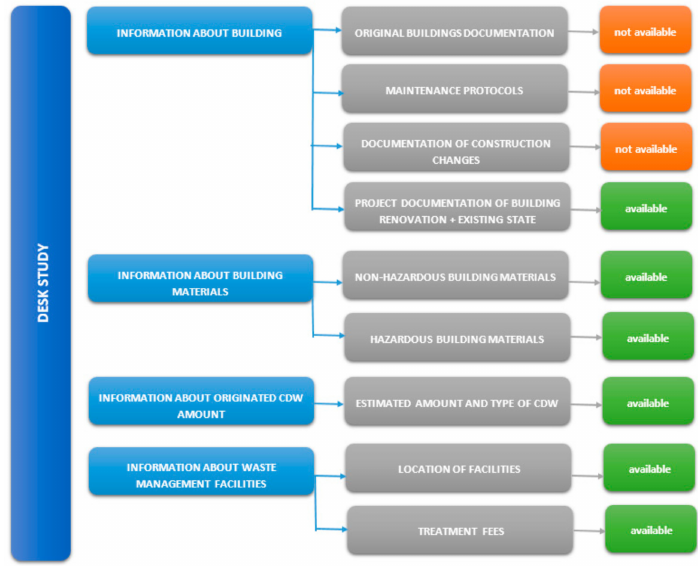
Figure 4. Steps of desk study for construction and demolition waste